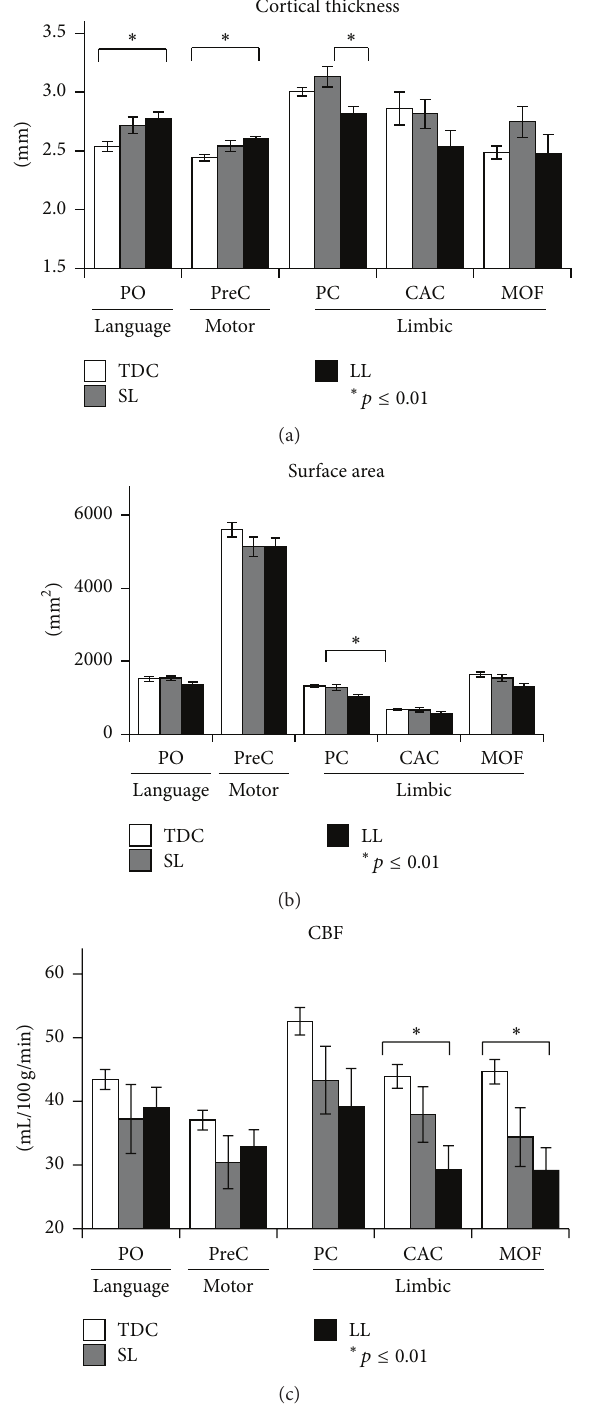
Figure 4: Means and standard deviations of cortical brain areas in which significant group differences ( 𝑝 ≤ 0.01 ) for cortical thickness (a),surfacearea(b),andcerebralbloodflow(CBF)(c)weredetected. The mean values are shown for the various anatomical locations of the cortical brain areas: motor area; language area; and limbic area and for the three different groups: control, small lesion (SL), and for the large lesion group (LL). PO: pars opercularis; PreC: precentral; PC: posterior cingulate; CAC: caudal anterior cingulate; MOF: medial